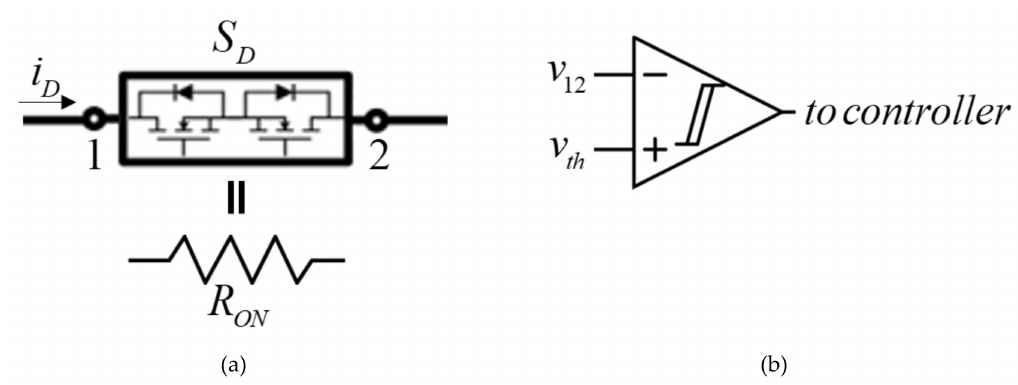
Figure 7. Utilizing MOSFET ON-resistance as a current-sensing shunt. ( a ) Switch S D structure; ( b ) SCS disconnection timing